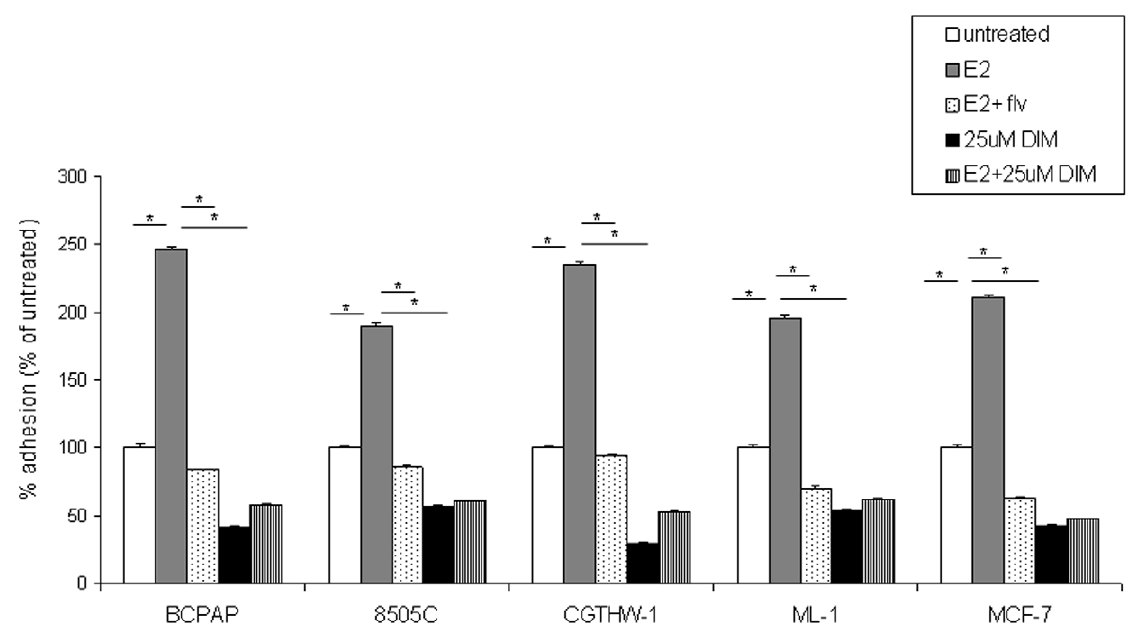
Figure 3. DIM decreases adhesion of thyroid cells. 5 6 10 5 cells were suspended in complete medium containing 6 10 2 8 M E 2 6 10 2 6 M fulvestrant 6 25 m M DIM and plated in 6 well culture dishes. After 2 hours viable adhered cells were removed by scraping and counted by trypan blue. The groups are as follows- untreated (white bars), E 2 treated (grey bars), E 2 + fulvestrant (dotted bars), 25 m M DIM (black bars), and E 2 + 25 m M DIM treated (striped bars). Data are expressed as % adhered cells compared to untreated cells which were set to 100% adhesion. Single asterisk denotes statistically significant differences ( p , 0.05) between the indicated samples.